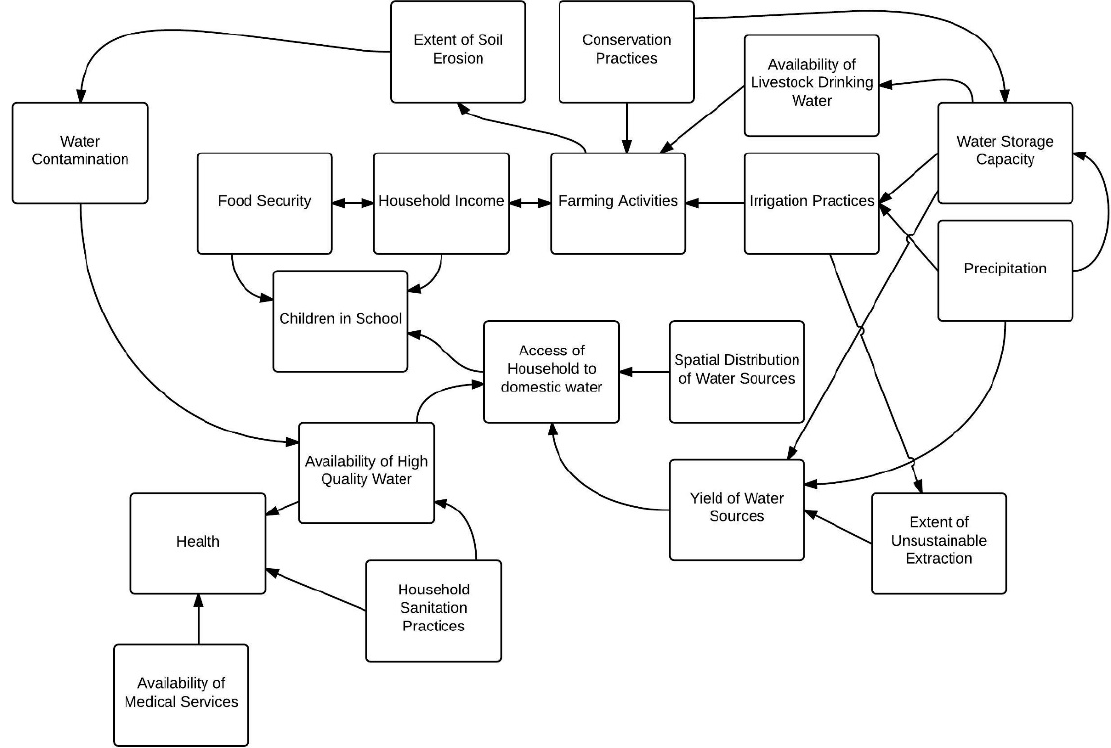
Figure 11. Interrelationships of various sectors related to water development.